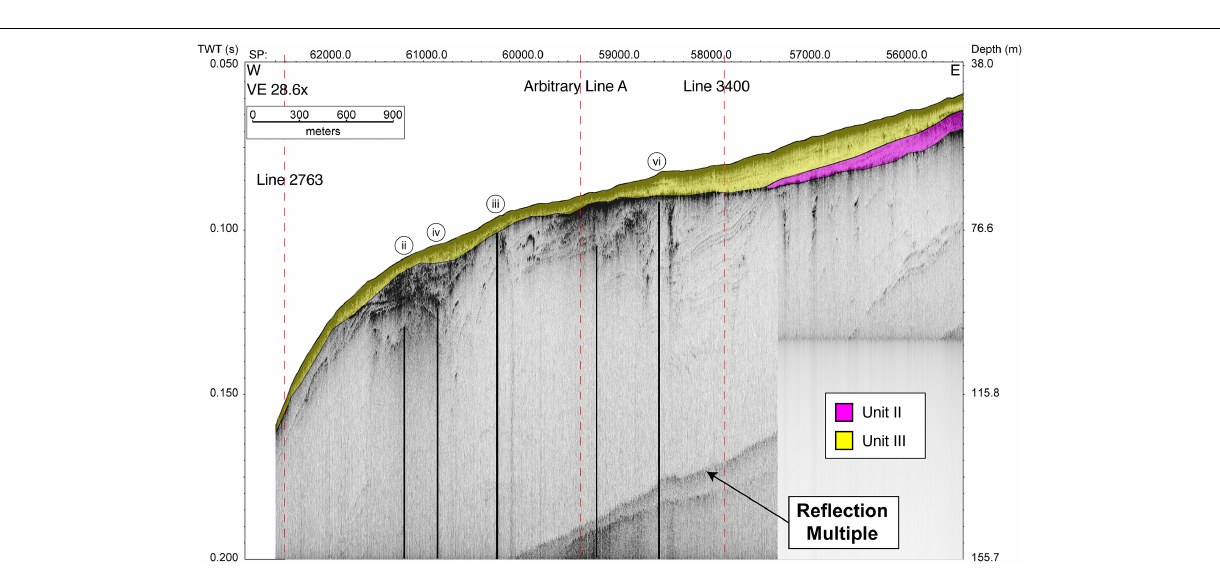
FIGURE 10 | CHIRP seismic profile from 50 to 200 ms ( ∼ 38–156 m) depth. Red dashed vertical lines show locations of other crosslines and arbitrary line. Major faults shown in black are labeled. Mapped units II and III are correlated to interpretations published by Klotsko et al. (2015). Multiple is